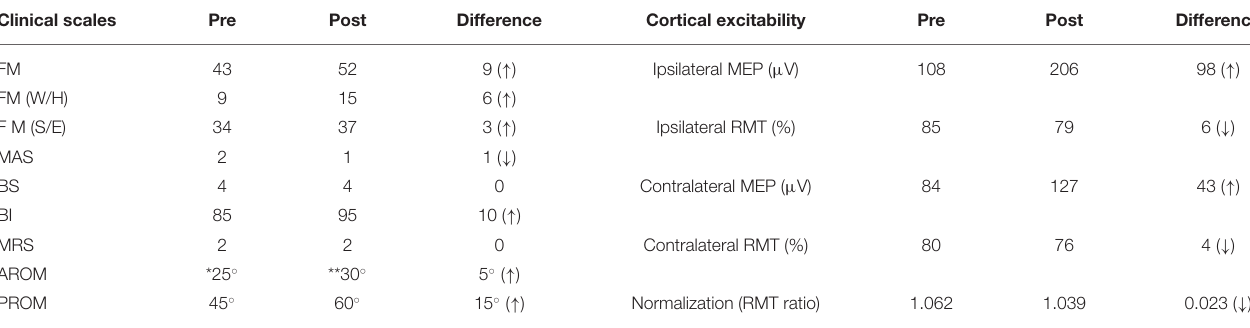
TABLE 1 | Details of clinical scales, cortical excitability measures. Clinical scales